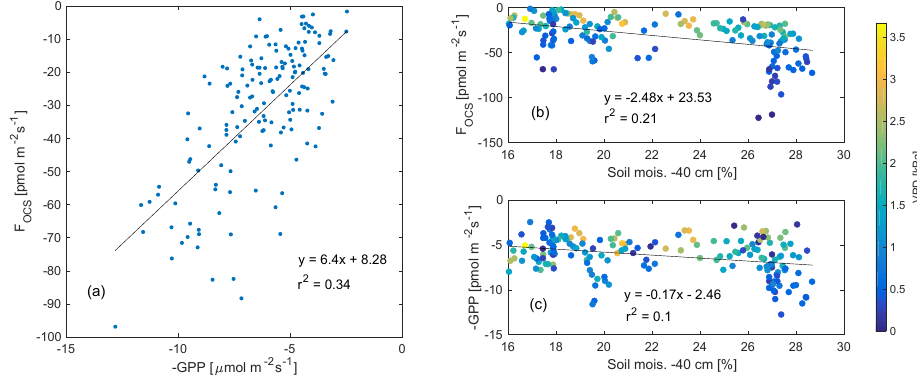
Figure 3. F OCS was linearly correlated to GPP (plotted as a negative quantity to show ecosystem uptake a ), while both F OCS and GPP reduced as a function of decreasing soil moisture (b–c) . Data presented here are midday means; data in (b–c) are colored according to VPD.